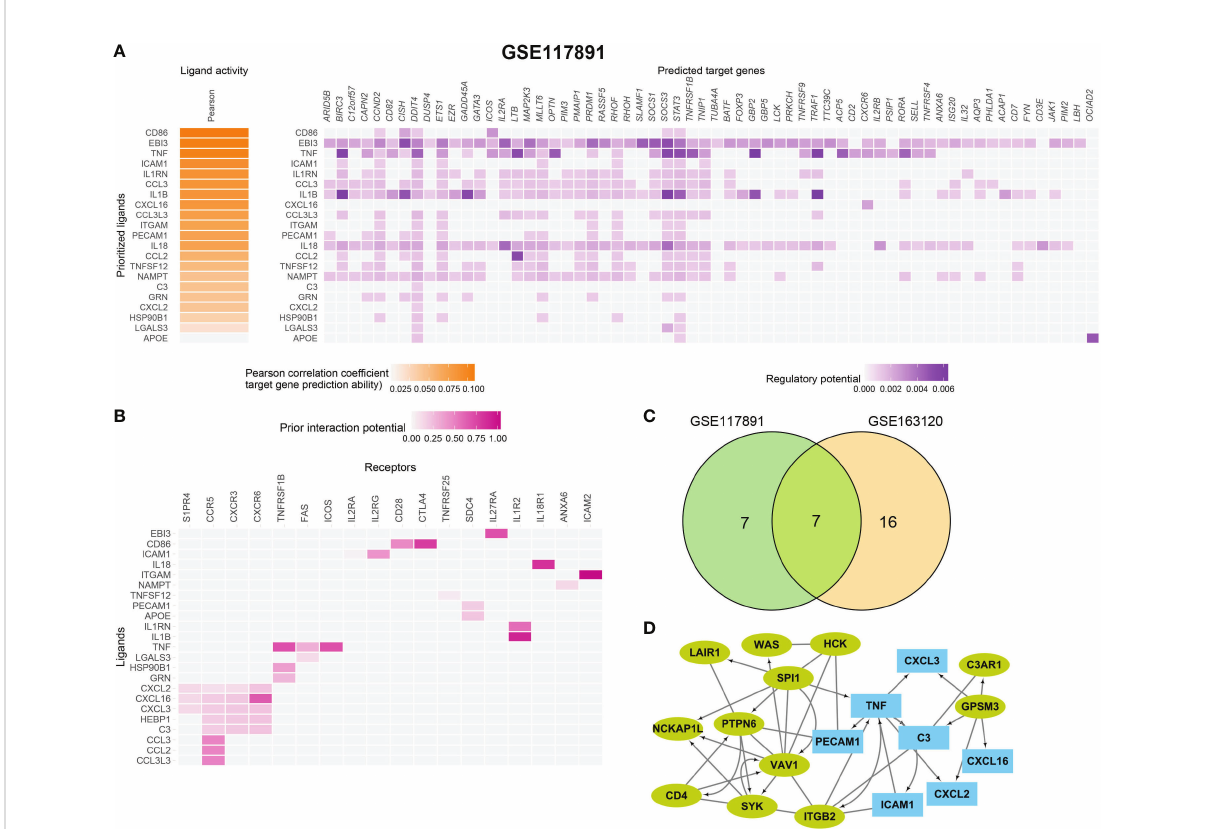
FIGURE 5 Macrophage and microglia cells shape an immunosuppressive microenvironment through interaction with Tregs in GSE163120. (A) A heatmap showing the predicted ligand activity by NicheNet on genes highly expressed in Treg. Pearson correlation indicates the ability of each ligand to predict the target genes, and better predictive ligands are thus ranked higher. (B) A dot heatmap showing the selected ligand-receptor pairs between macrophages or microglia and Treg cells. Benjamini – Hochberg adjusted permutation test. (C) The intersection between top ligands from both datasets, seven ligands in macrophage/microglia were detected. (D) protein – protein interaction between Top15_hub genes (colored in yellow green) and seven ligands (colored in sky blue) with both directed and undirected interaction. The directed interaction was shown in arrows. Some Top15_hub genes were involved in the regulation of